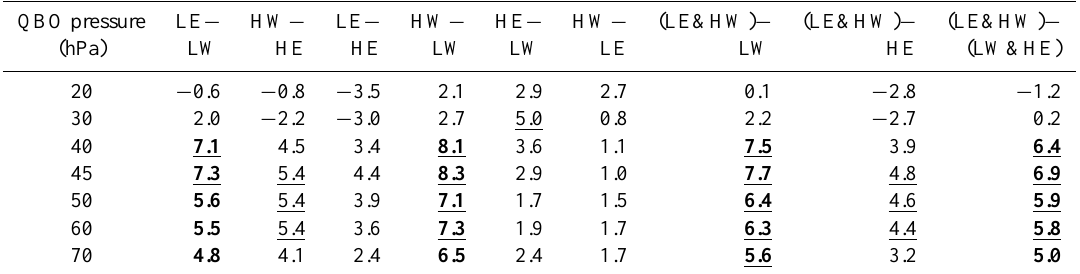
Table 3. Difference in temperature between the groupings presented in Table 2. Values estimated to be significant at the [90, 95, 99]% level are given in [underlined; bold; bold and underlined] type. QBO